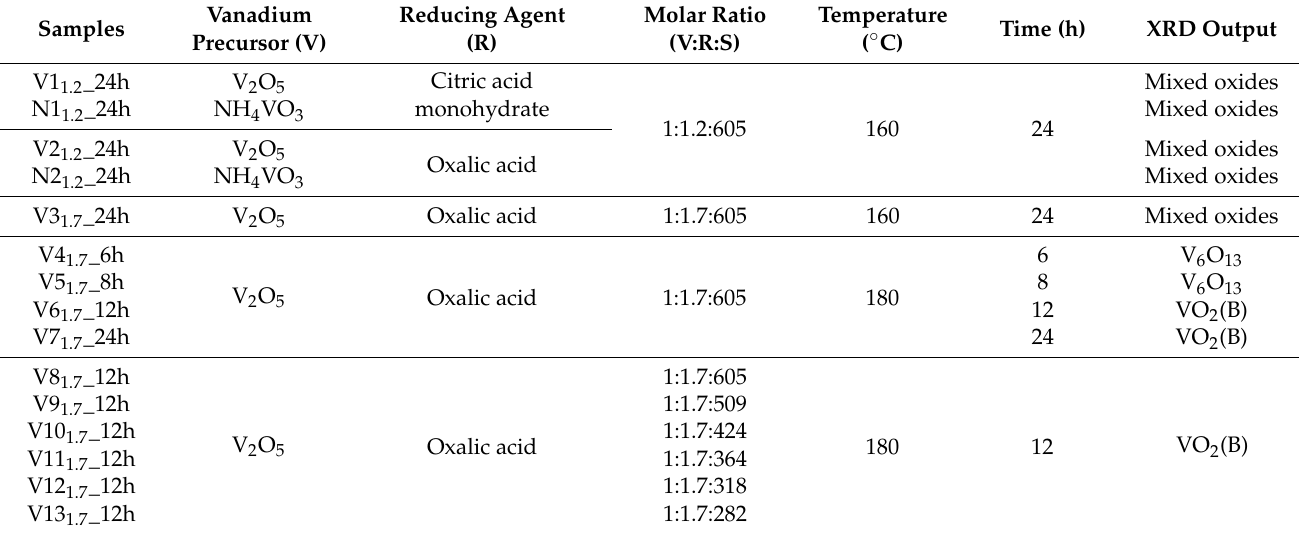
Table 1. List of the samples synthesized via hydrothermal synthesis by changing the vanadium precursors, the molar ratios vanadium precursor (V)/reducing agent (R)/solvent (S), the temperature, and the reaction time.